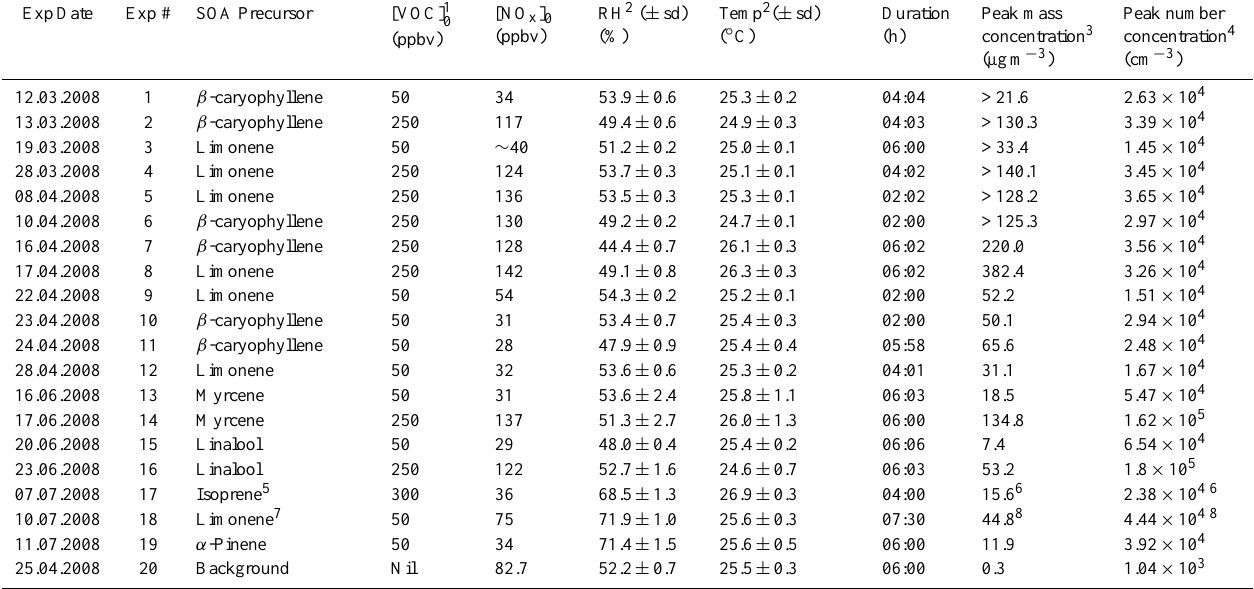
Table 1. Experimental details of chamber experiments used to build the mass spectral